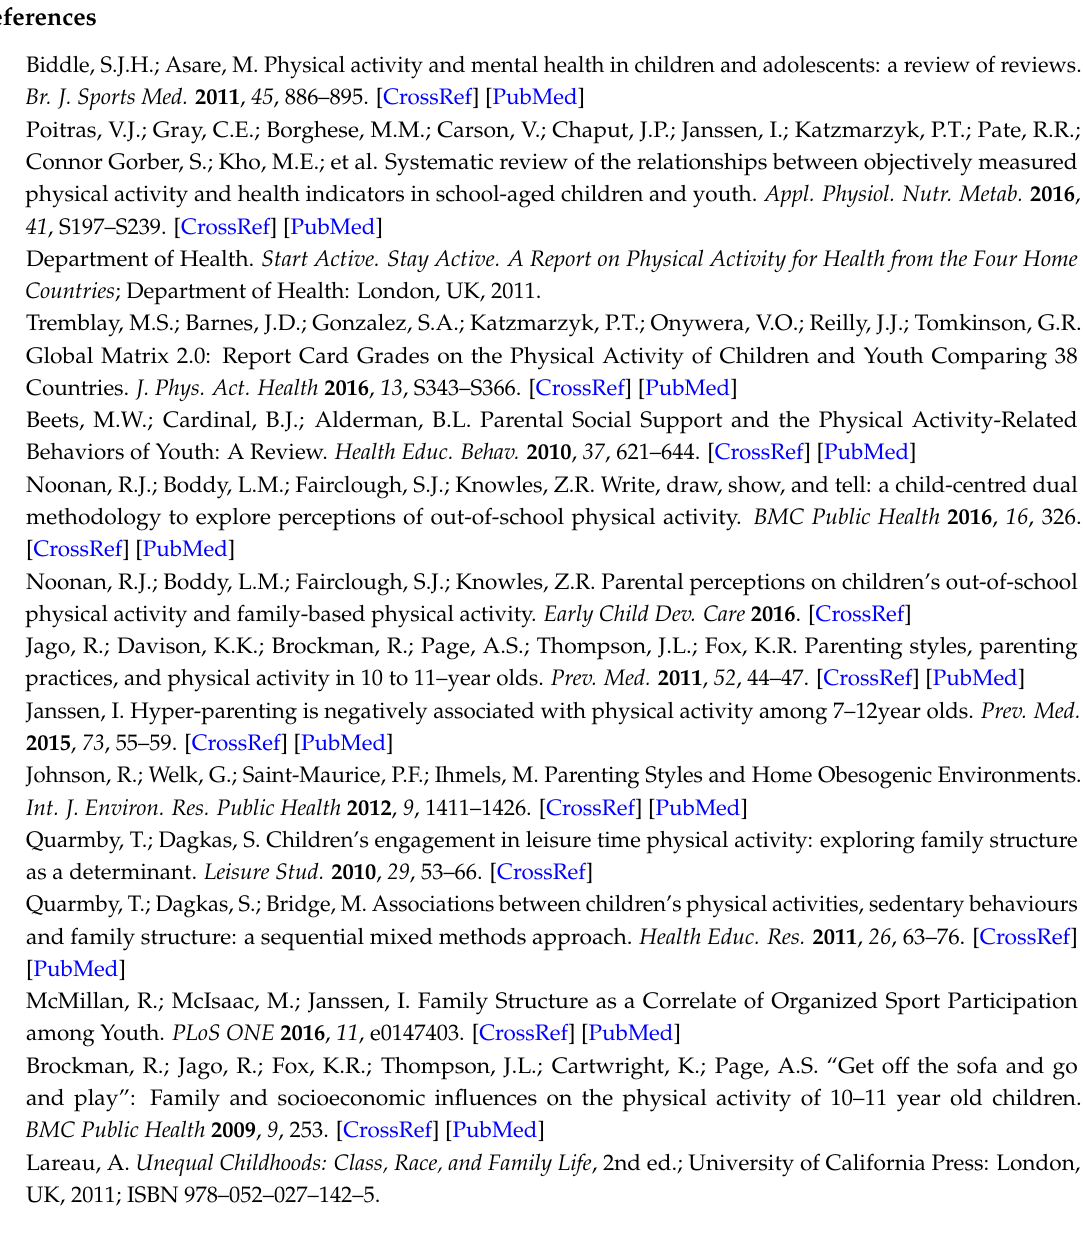
Figure S1: Physical activity diary data for weekdays and weekend days for each participant and data collection